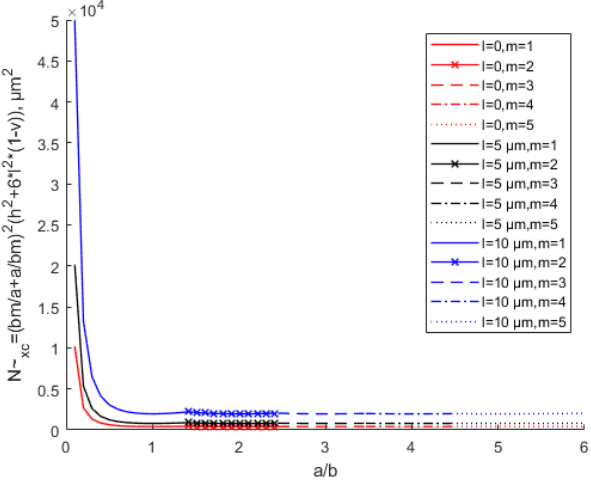
Figure 10. Variation in the equivalent critical buckling load with various values of the scale parameter